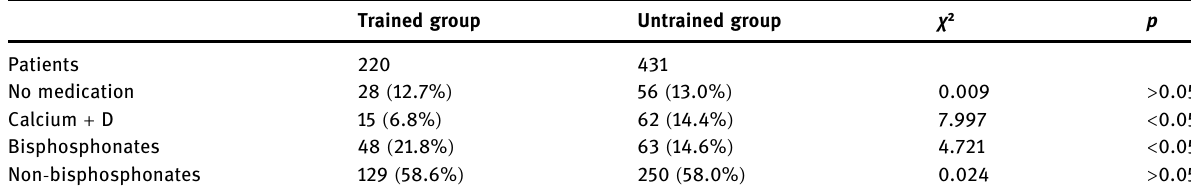
Table 2: Comparison of drug therapies for osteoporosis between the trained group and untrained group [ n , ( % )] Trained